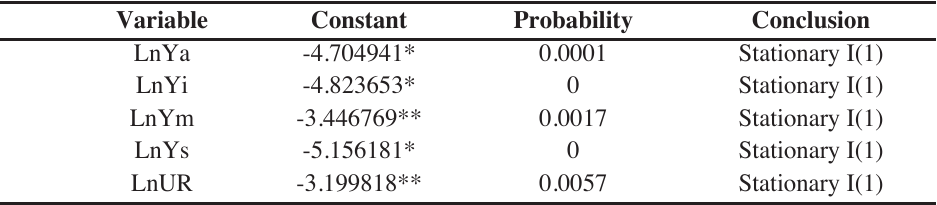
ADF First Difference